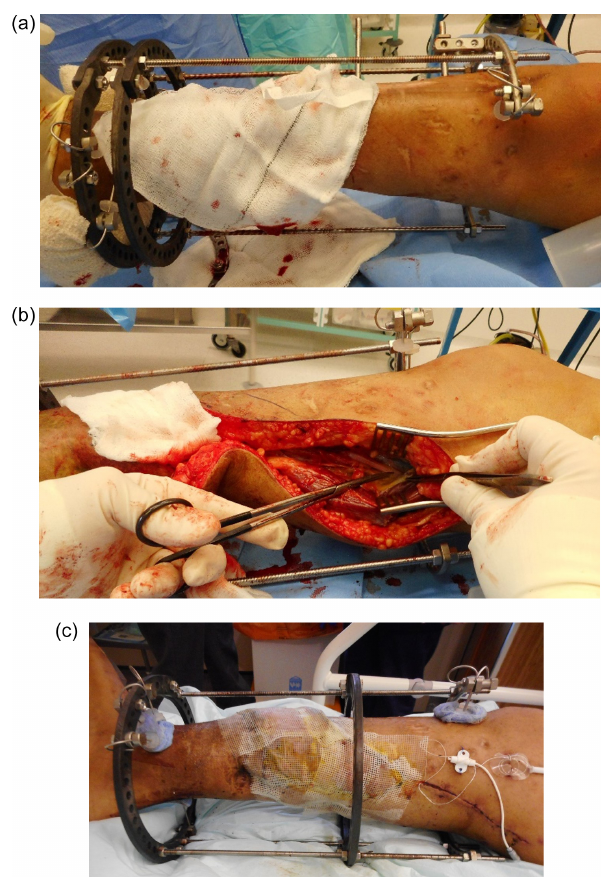
Figure 2. This young man suffered a fracture through an area of chronic osteomyelitis, after a previous Ilizarov bone transport. It was treated conservatively but developed a hypertrophic non-union with shortening. He was referred to us with a painful, stiff non- union and a large anteromedial ulcer. A simplified Ilizarov frame with a partial proximal ring has been applied to temporarily stabi- lize the tibia (a) , after excision of the ulcer and dead bone at the fracture site. The central ring of the frame has been moved distally (by sliding along the rods) and the medial rods are absent. The only patent recipient vessels were in the proximal part of the calf. This highly modified frame allowed good access for microsurgery (b) . After surgery (c) , the central ring has been moved to its proper po- sition on the diaphyseal half pin. Further rods and hinges are applied later to improve stability. Temporarily leaving out the final rods, and ring segments allows continued access to the anastomosis, if early problems arise. These must be applied before mobilisation and be- fore monofocal distraction